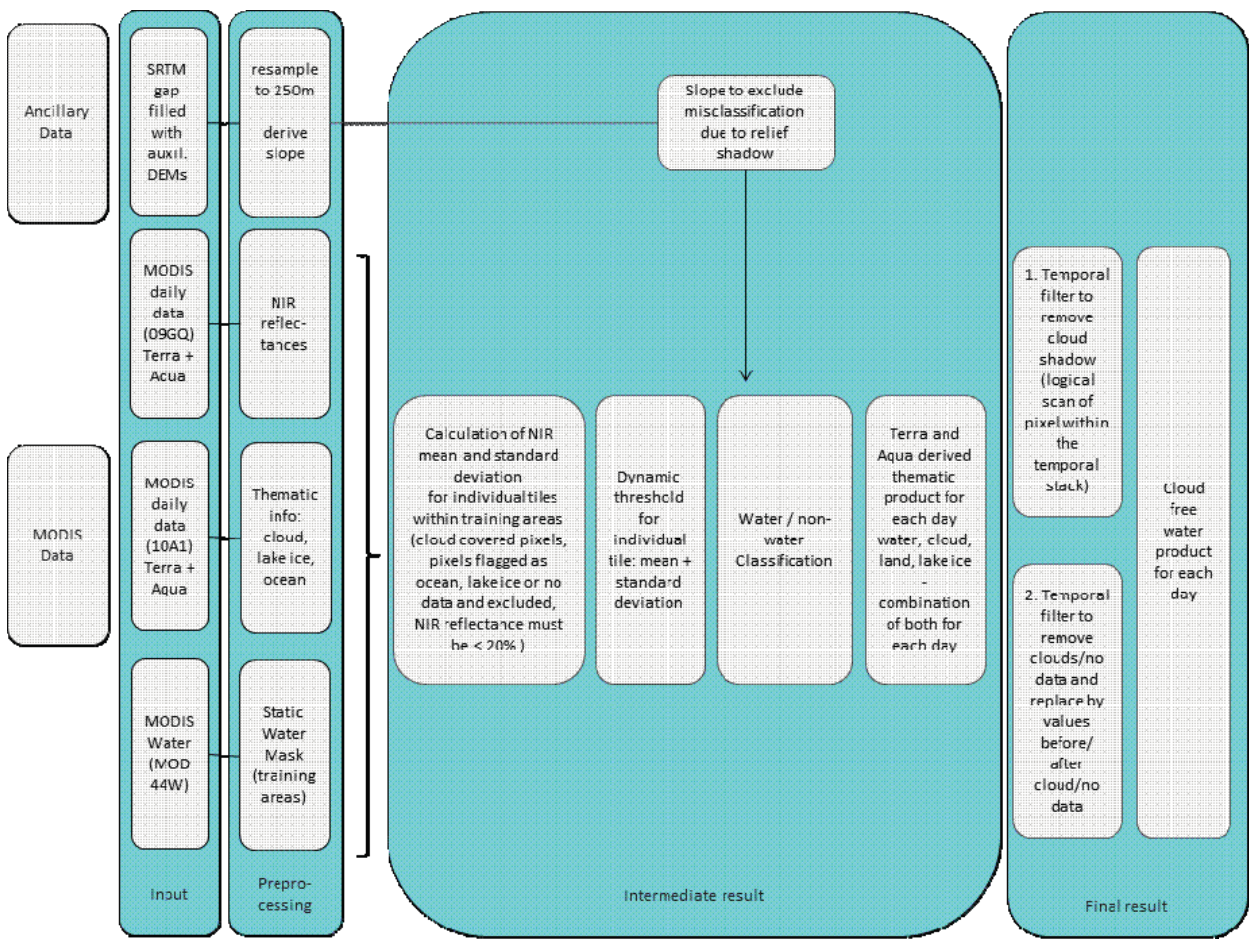
Figure 1. Processing chain of MODIS data and ancillary data for deriving